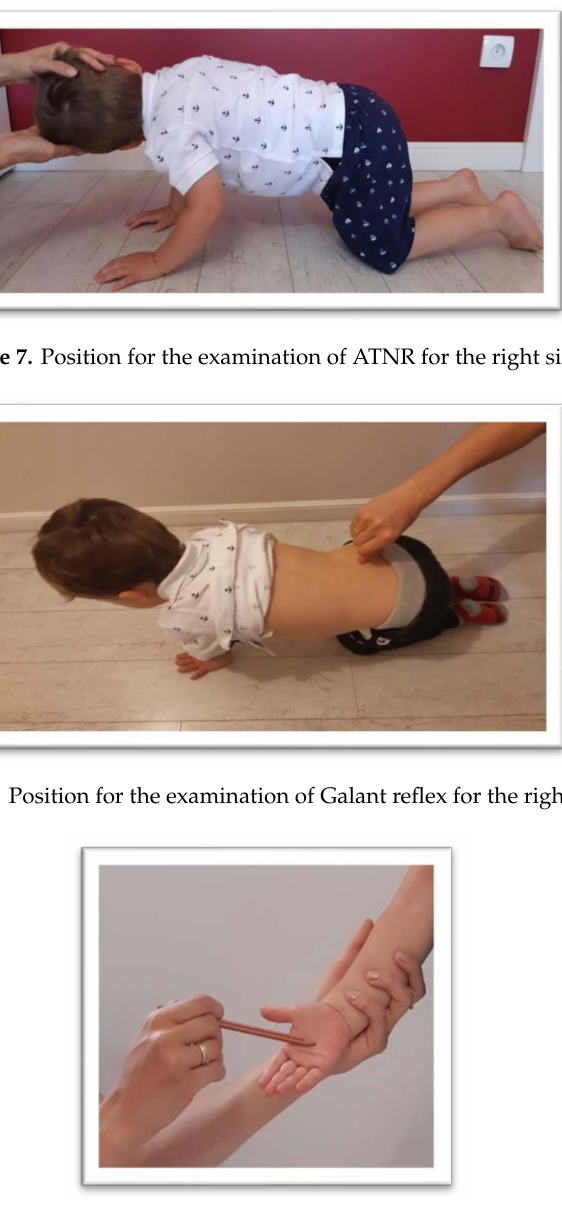
Figure 9. Position for the examination of Palmar reflex for the right